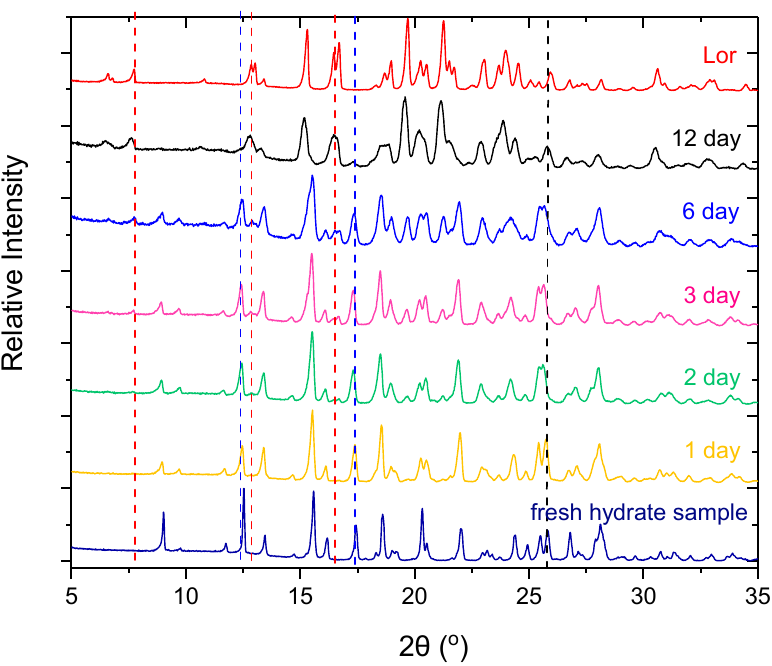
Figure 8. PXRD patterns of Lor-Oxa hydrate powder stored at 100 °C .